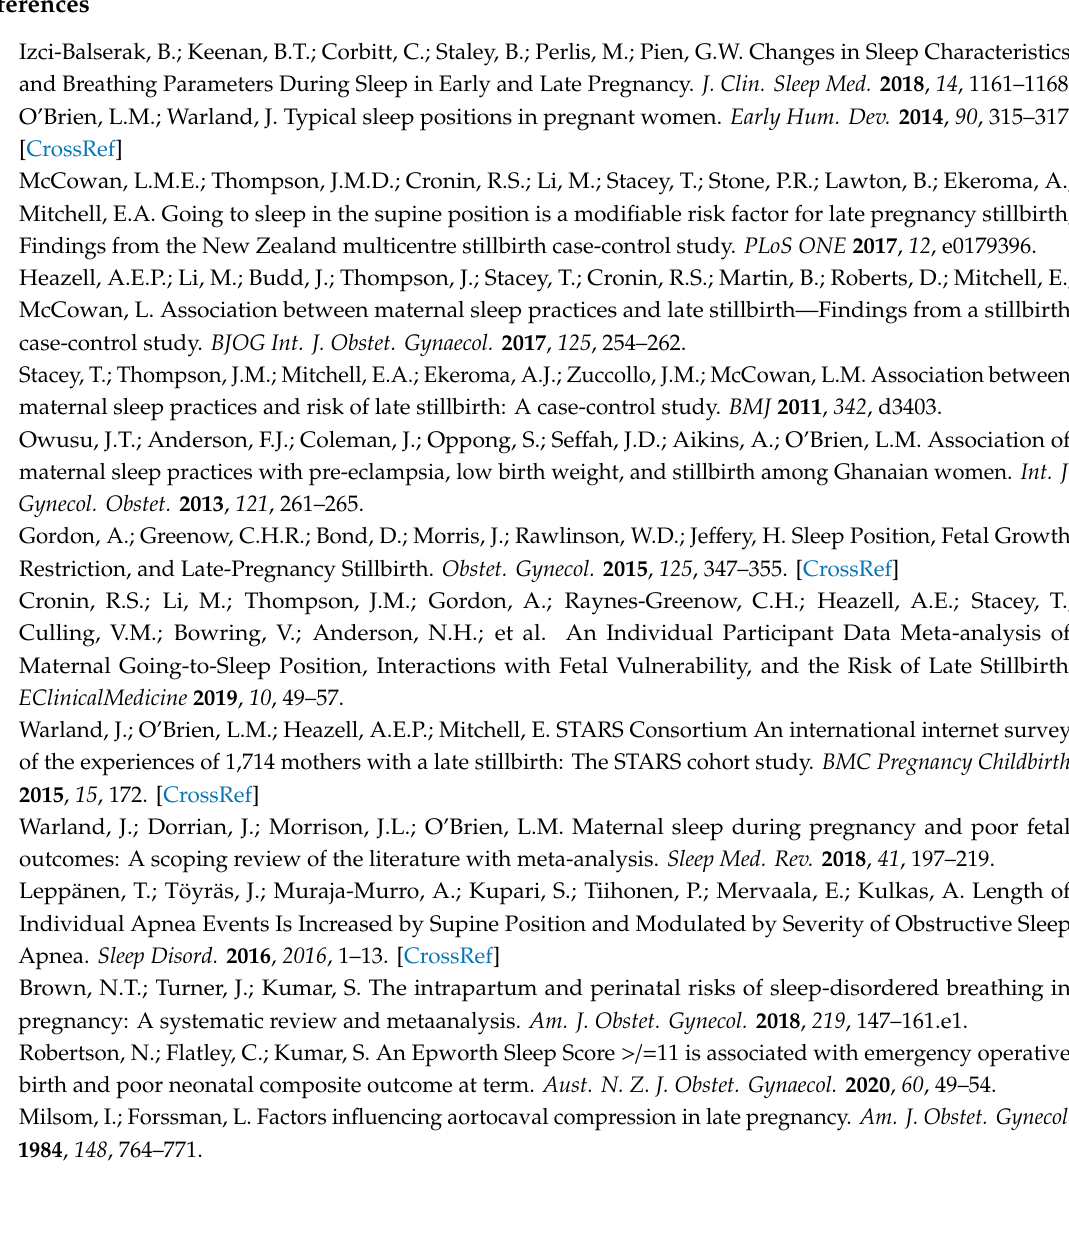
Table S1. Sleep questionnaire, Supplementary Table S2: Maternal demographics by cerebral